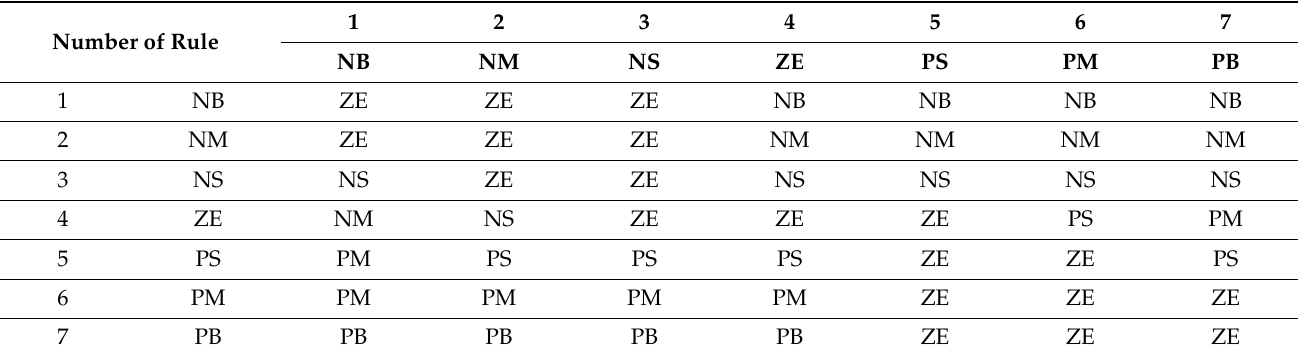
Figure 3. Input membership function for voltage. Table 1. Rule base for fuzzy controller [27,28].